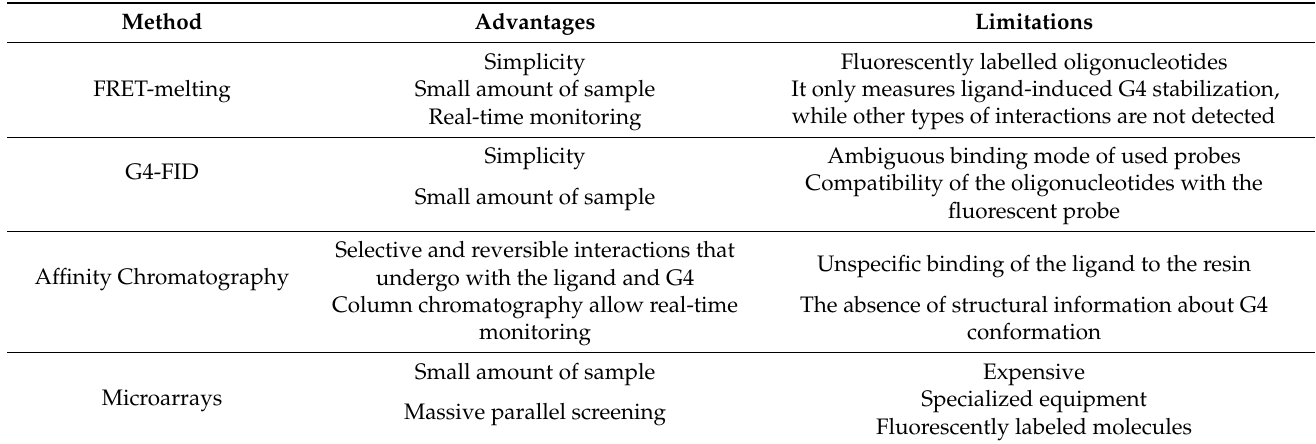
Table 3. Advantages and limitations of high-throughput methods for investigating G4/ligand interactions.